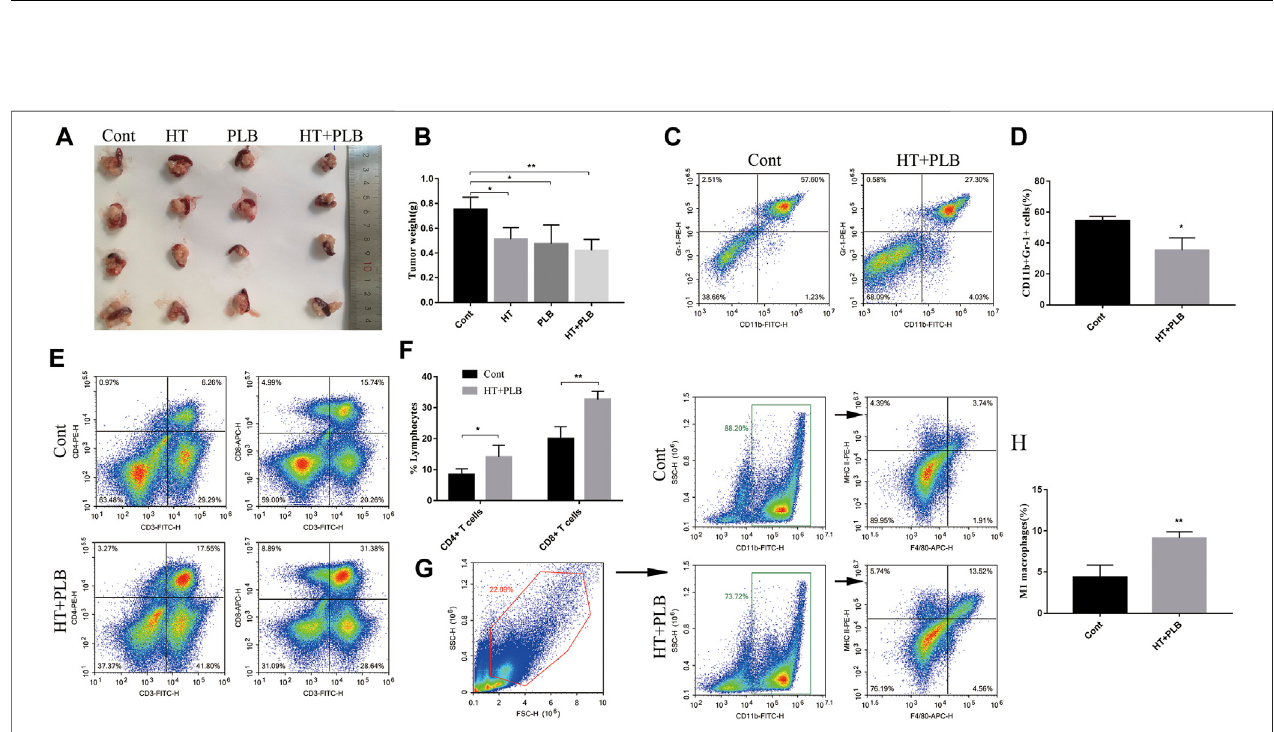
FIGURE 7 | HT combined with PLB therapy reshapes the immune microenvironment of pancreatic cancer in mice. The mice with orthotopic pancreatic tumor receivedHTcombinedwithPLB(HT200 mg/kg,PLB1 mg/kg)andnormalsalineintraperitonealtreatmentfor10 days.Representativetumors invivo (A) ,andthetumor weightwascompared( n (cid:2) 4ineachgroup) (B) (* p < 0.05,** p < 0.01).Tumortissuesin fi ltrating-MDSCs( n (cid:2) 3ineachgroup) (C,D) ,CD4 + ( n (cid:2) 4ineachgroup)andCD8 + T cells ( n (cid:2) 3 in each group) (E,F) , M1 macrophages ( n (cid:2) 3 in each group) (G,H) in the control group and the combination therapy group were analyzed and compared (* p < 0.05, ** p < 0.01).